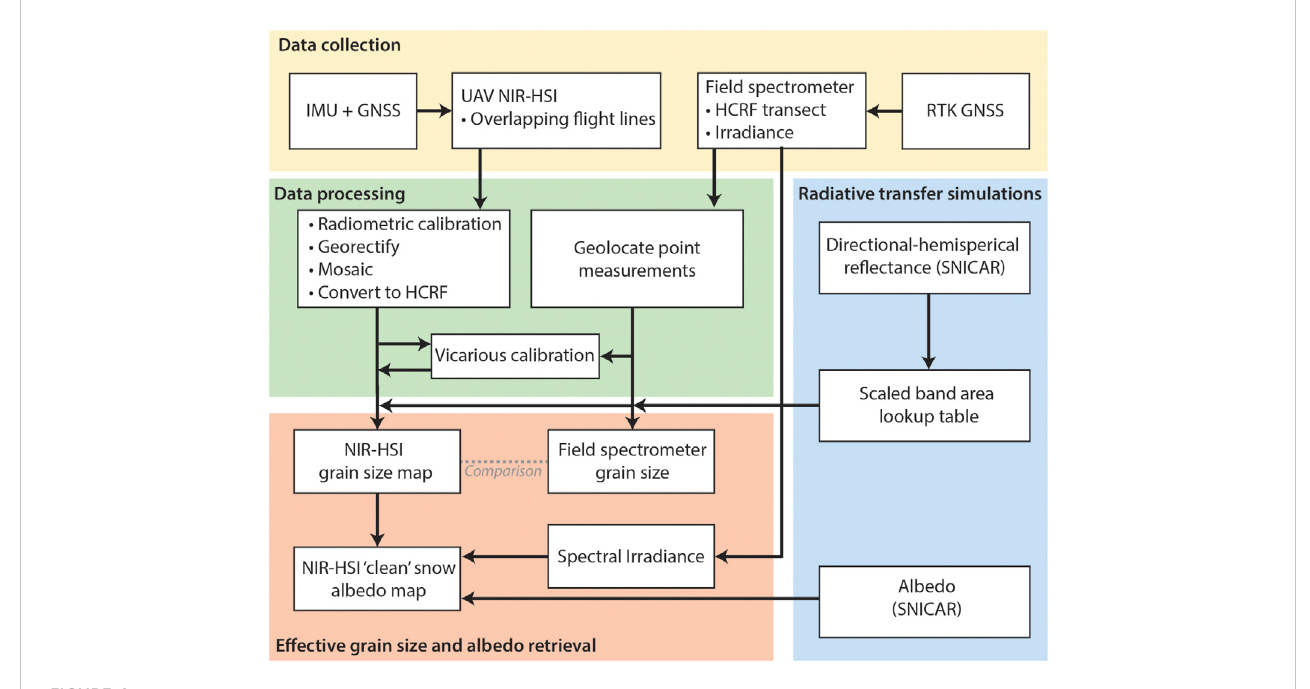
FIGURE 4 Overview of UAV-HSI and fi eld spectrometer processing steps.